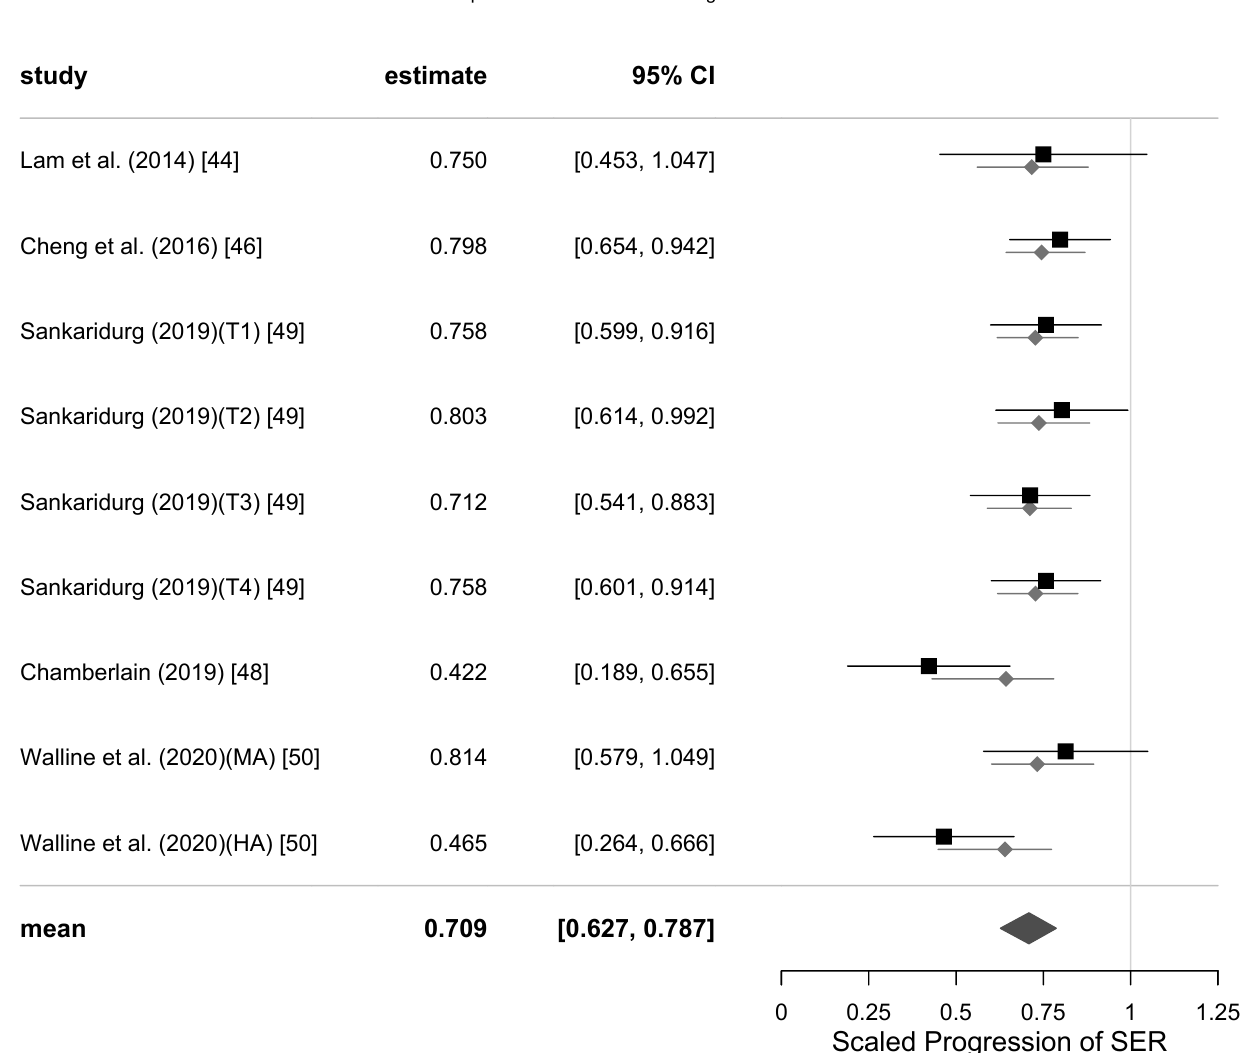
Figure 8. Forest plot for the scaled progression of sphere equivalent refraction (SER) at the 12-months follow-up in the set of 9 interventions using soft multifocal contact